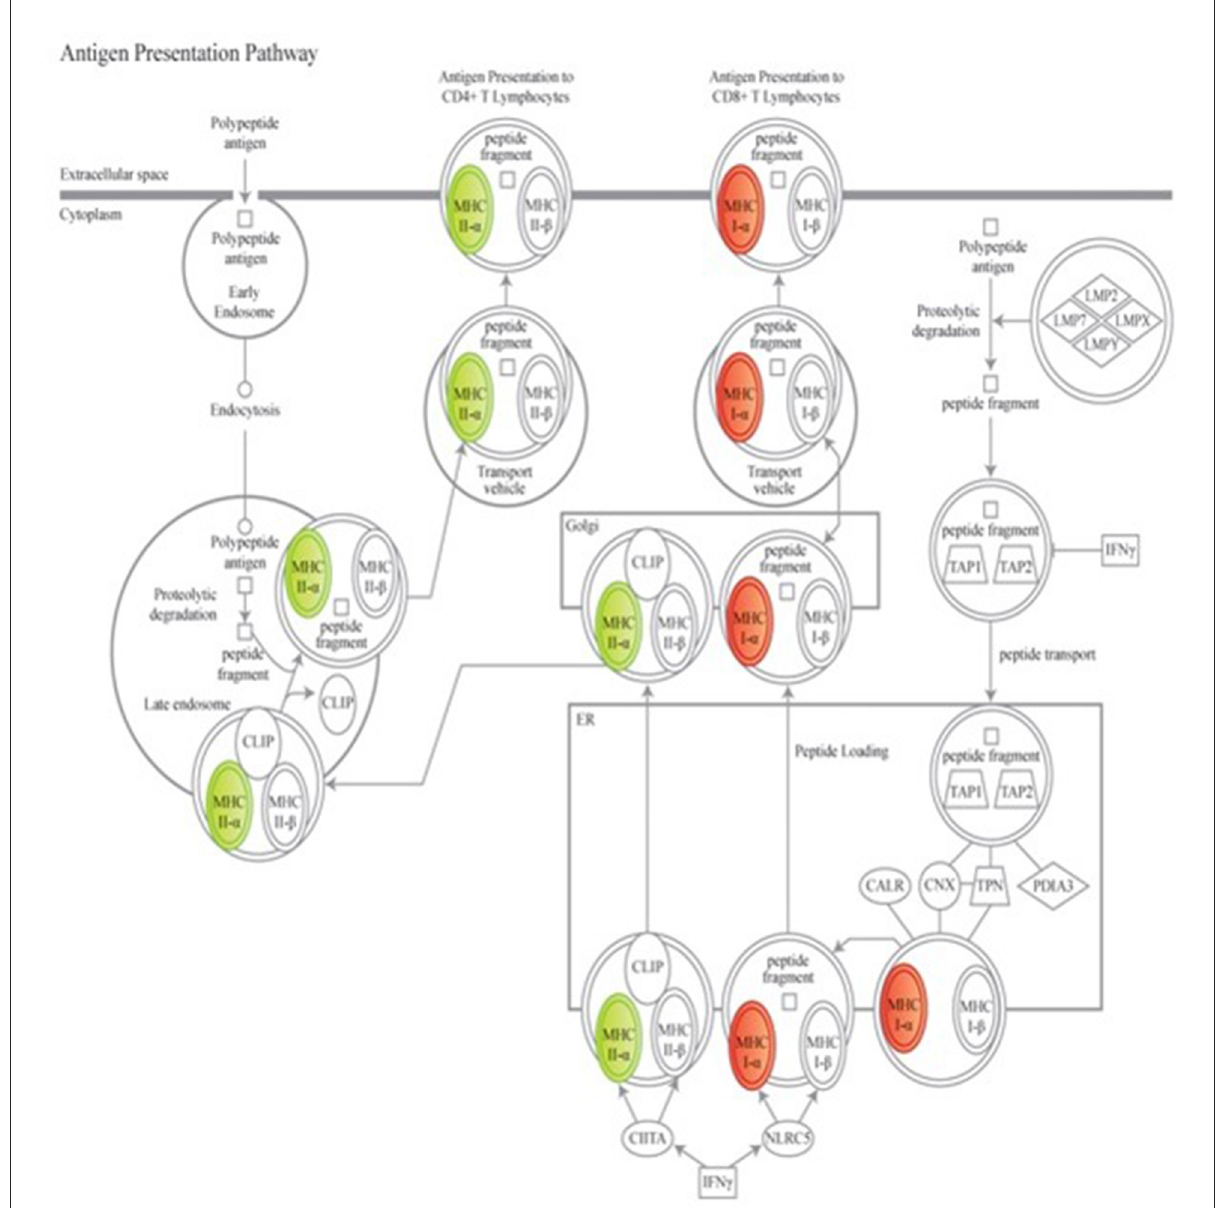
FIGURE2 Genes associated to the antigen presenting canonical pathway are associated to a protective vaccine profile. The cartoons illustrate expression changes in genes associated to Non-Infected Gudair ® treated and MAP exposed sheep in comparison to similarly treated Infected sheep. Genes and the predicted downstream response are highlighted in color. Color intensity indicates the degree of increased (red) or decreased (green) relative expression and suggest a suppression of antigen presentation to CD4 + T cell lymphocytes but enhanced presentation to CD8 + T cell lymphocytes. Detailed explanation for figure notations is located at https://qiagen.my.salesforce-sites.com/KnowledgeBase/articles/ Knowledge/Legend.